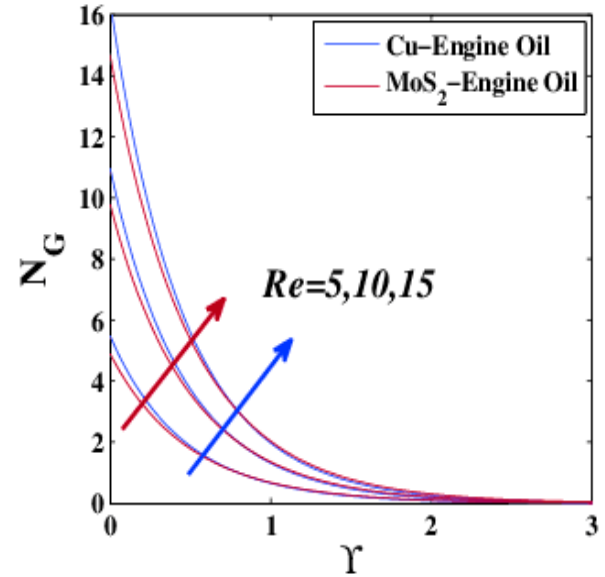
Figure 30. Entropy generation variation N G under the influence of Re .